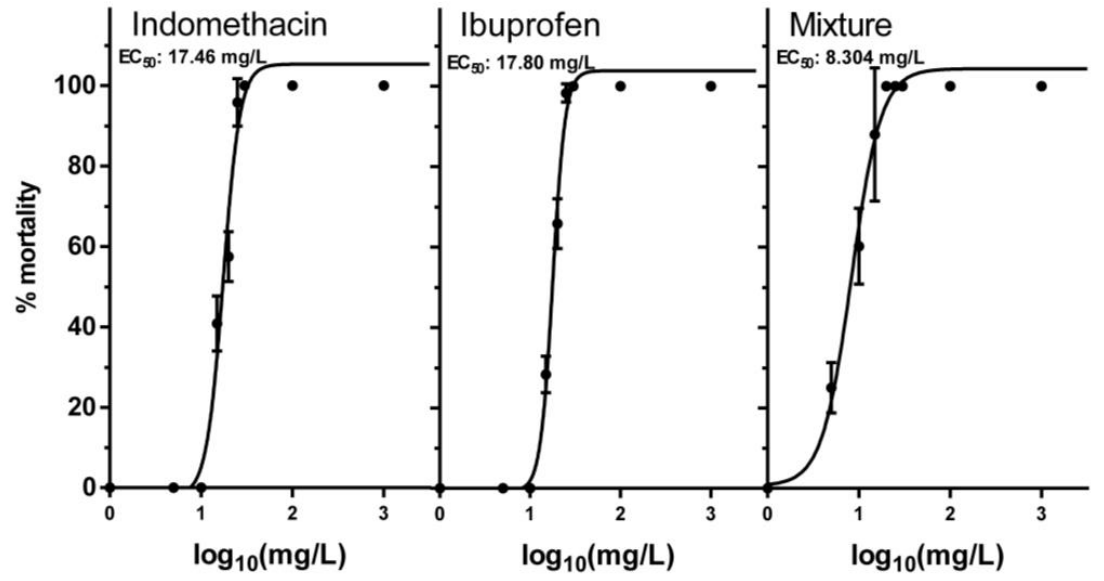
Figure 2. Acute toxicity curves in neonates for indomethacin, ibuprofen, and their mixture. Data represent average ± standard deviation (N = 4 replicates). Table 1. EC values (in mg/L) from toxicity curves.